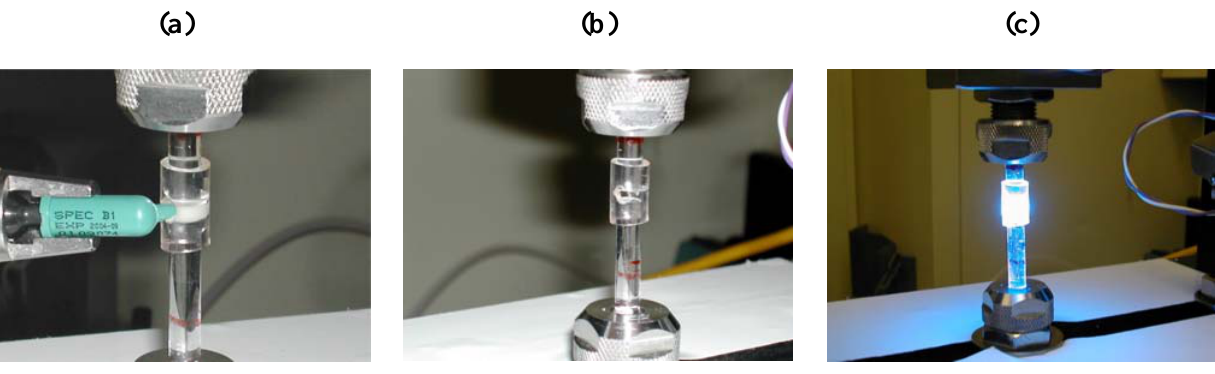
Figure 7. Positioning tygon (a), filling the mold (b) and light curing of the specimen (c) in the